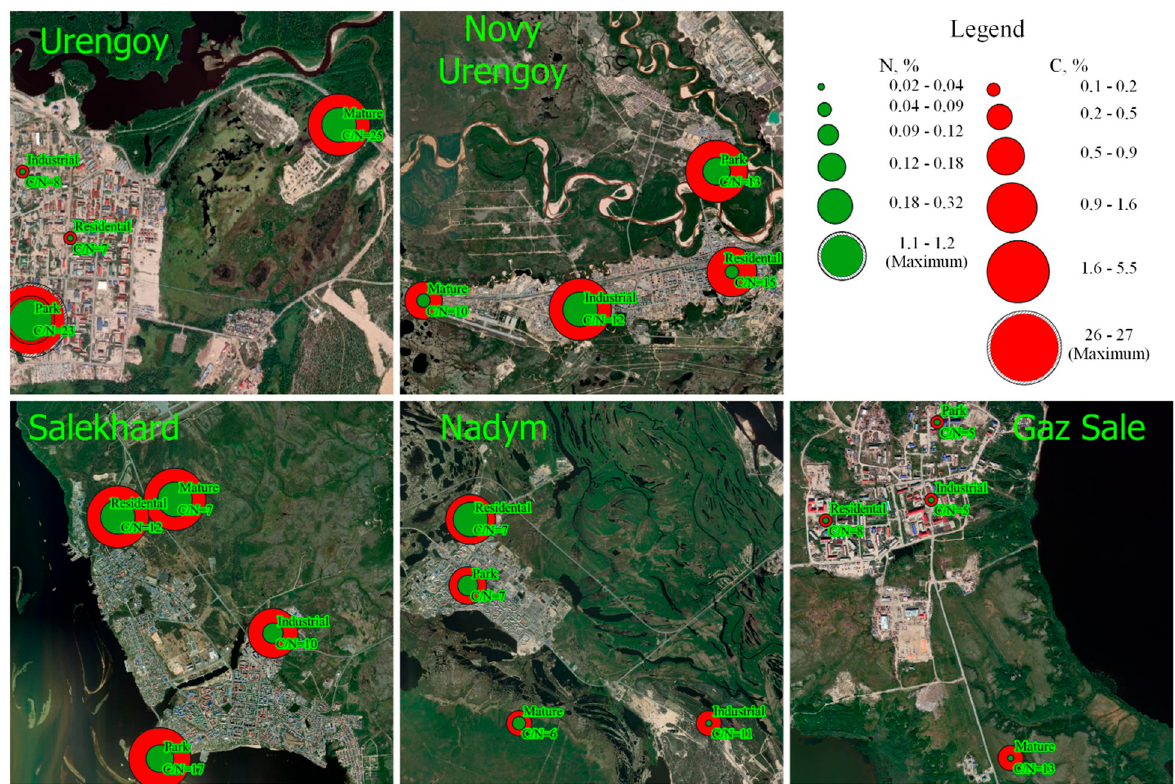
Figure 5. Contents of total organic carbon (TOC), total nitrogen (TN), and C/N ratio values for the studied